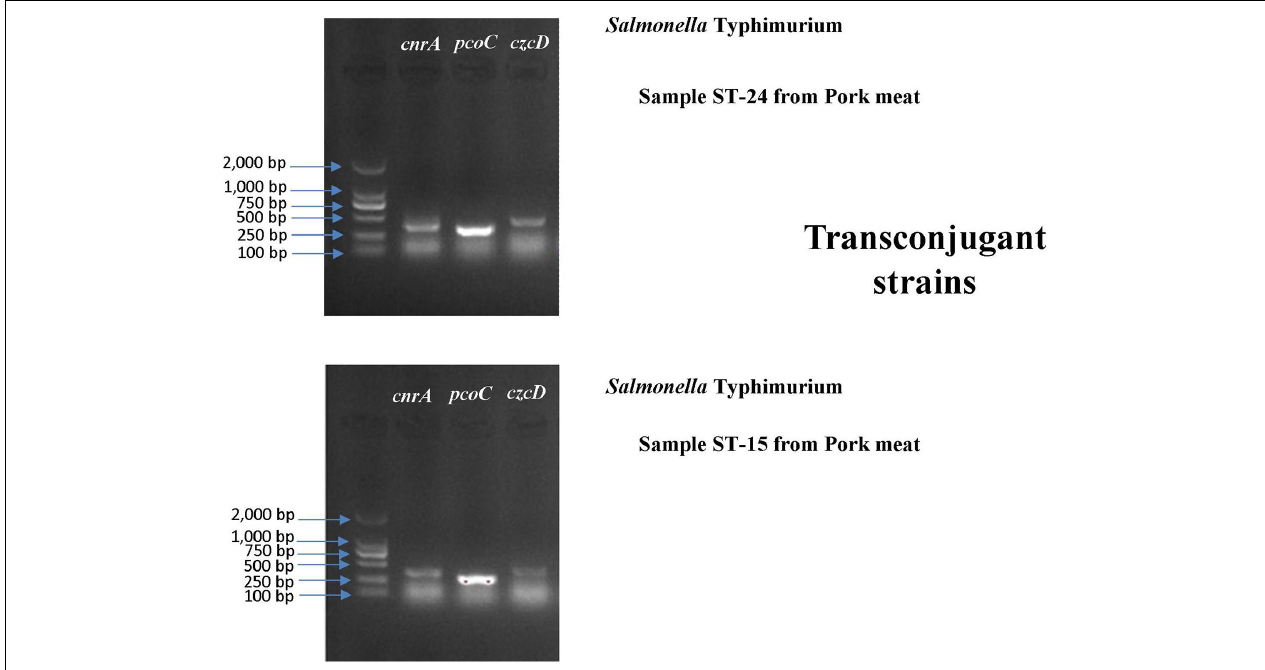
FIGURE 6 | Gel electrophoresis verification of the transfer of cnrA, pcoC and czcD from Salmonella Typhimurium isolates S15 and S24 to Escherichia coli J53.